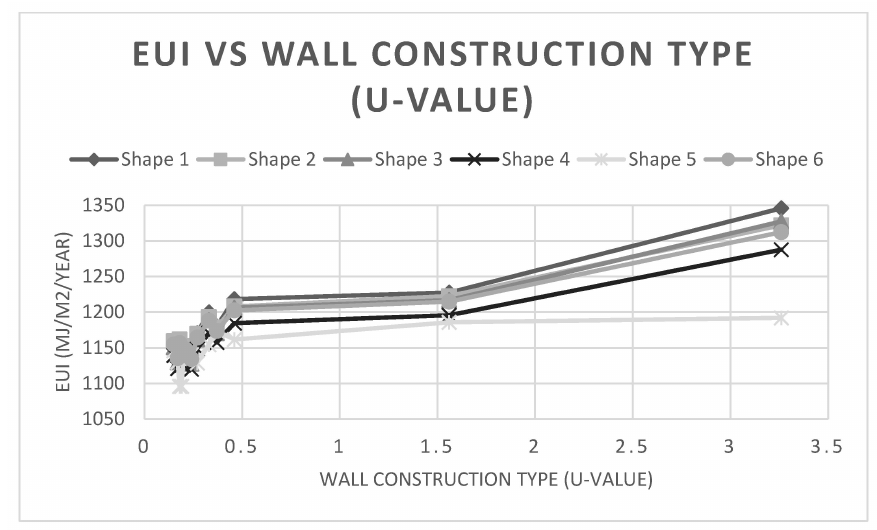
Figure 8. EUI of shapes vs. wall construction type (U-Value).